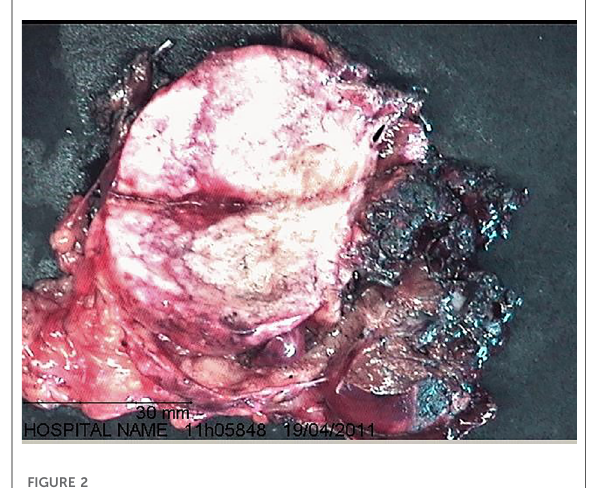
FIGURE 2 Predominantly extrahepatic indurated tumoral mass.